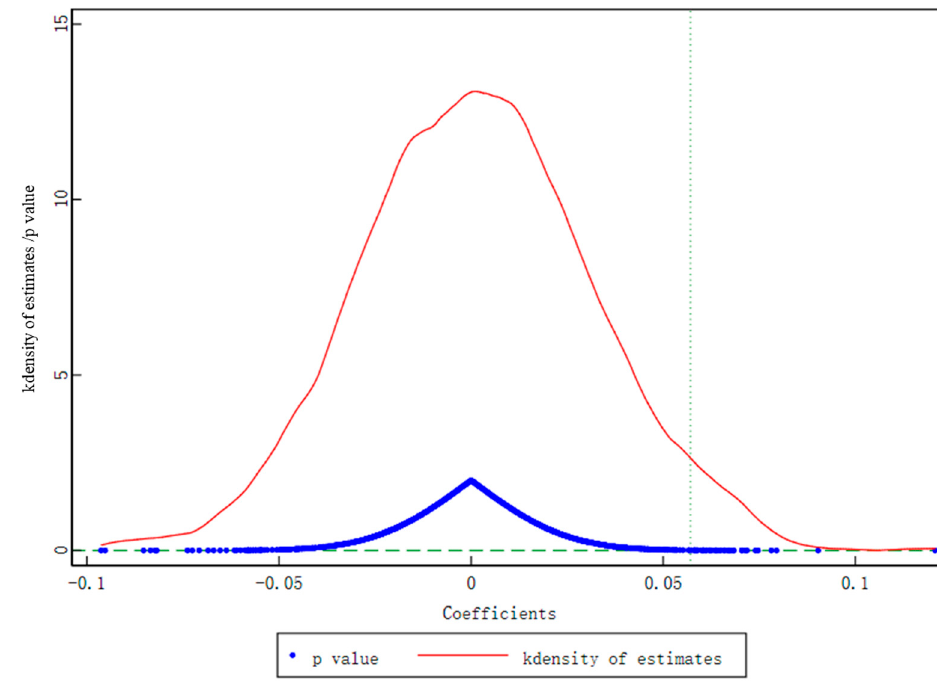
Figure 6. Placebo test results. Table 6. Change the research